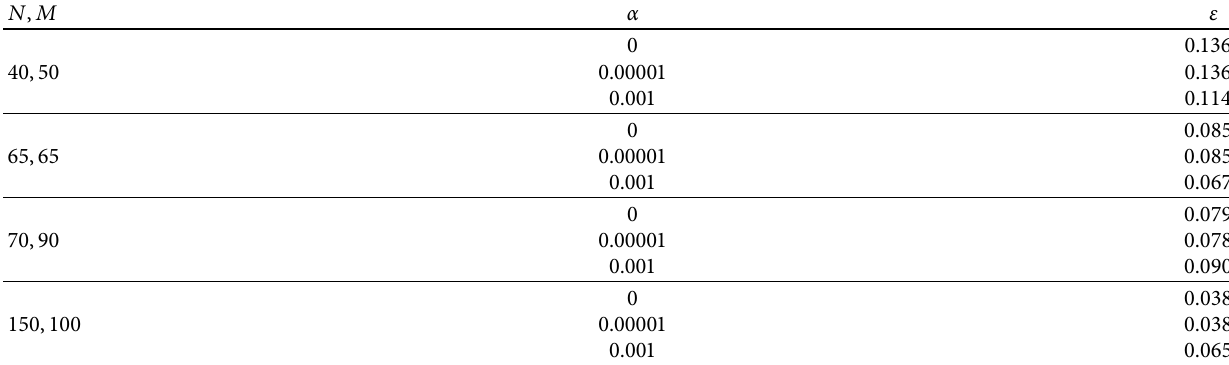
Table 1: Error analysis for system (15) with τ � π / N and h � π / M .